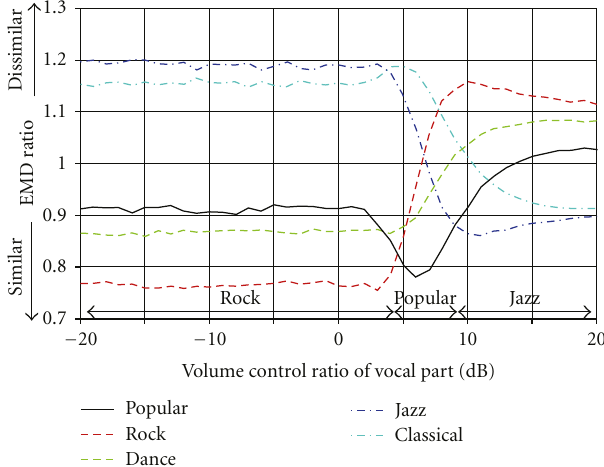
0.70.80.911.11.21.3 Figure 6: Ratio of average EMD per genre to average EMD of all genres while reducing or boosting the volume of single instrument part. Here, (a), (b), and (c) are for the vocal, guitar, and drums, respectively. Note that a smaller ratio of the EMD plotted in the lower area of the graph indicates higher similarity. (a) Genre classification shift caused by changing the volume of vocal. Genre with the highest similarity changed from rock to popular and to jazz. (b) Genre classification shift caused by changing the volume of guitar. Genre with the highest similarity changed from rock to popular. (c) Genre classification shift caused by changing the volume of drums. Genre with the highest similarity changed from popular to rock and to